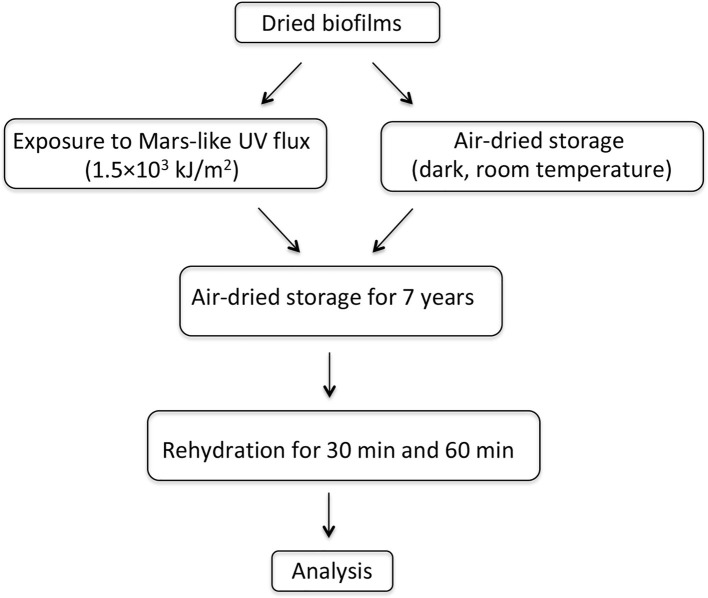
Experimental scheme.